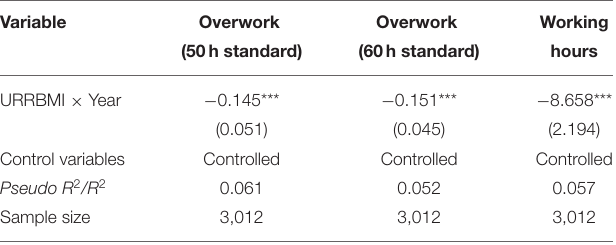
TABLE 5 | Double differential propensity score matching (PSM-DID).